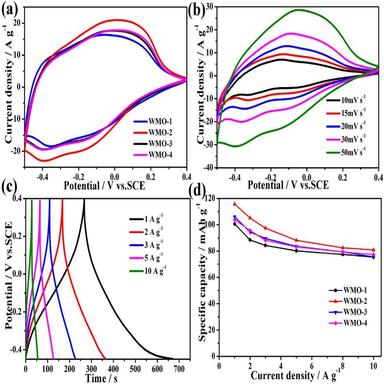
(a) CV curves for WMO-1, WMO-2, WMO-3, and WMO-4 at a scan rate of 30 mV s1 , (b) CV curves of WMO-2 at various current densities, (c) GCD curves of the WMO-2 at various current densities, (d) Specific capacitance of the WMO-1, WMO-2, WMO-3, and WMO-4 nanomaterials at various current densities.